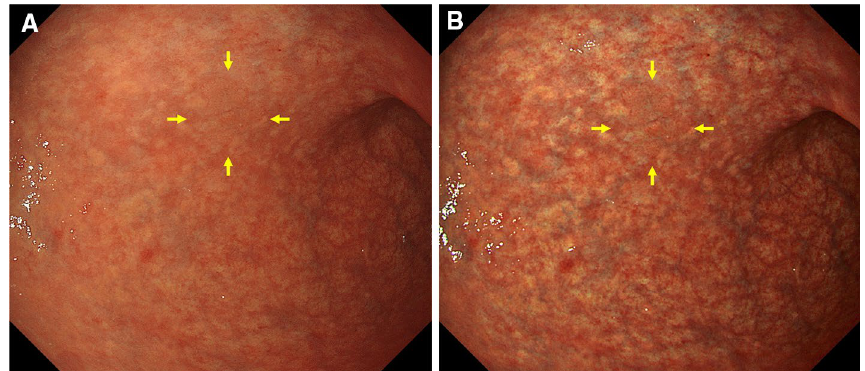
Figure 4. A representative case showing improved visibility on TXI. ( A )WLI displayed an isochromatic flat lesion in the anterior wall of the lower gastric body. Although there is a slight difference in surface structure, it is difficult to recognize. The median (IQR) visibility by 10 endoscopists was 2 (1–4). ( B ) TXI displayed enhancement of the structure of the EGC, and the mucosal atrophy in the background appeared more